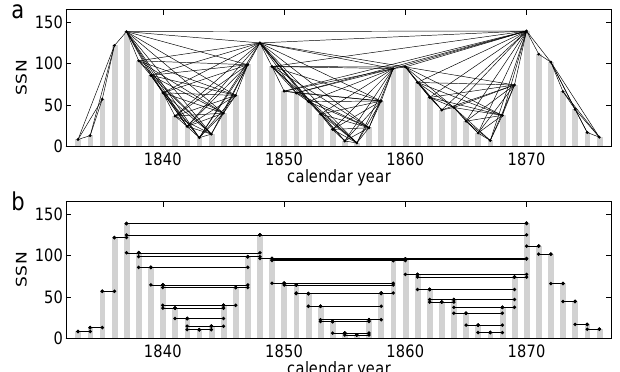
Figure 3. Schematic illustration of the algorithmic concepts behind (a) VG and (b) HVG using the same short subset of annual sunspot numbers (SSN) as an example. In both cases, two time points ful- filling the (horizontal) visibility condition are connected by a line indicating the presence of an edge in the